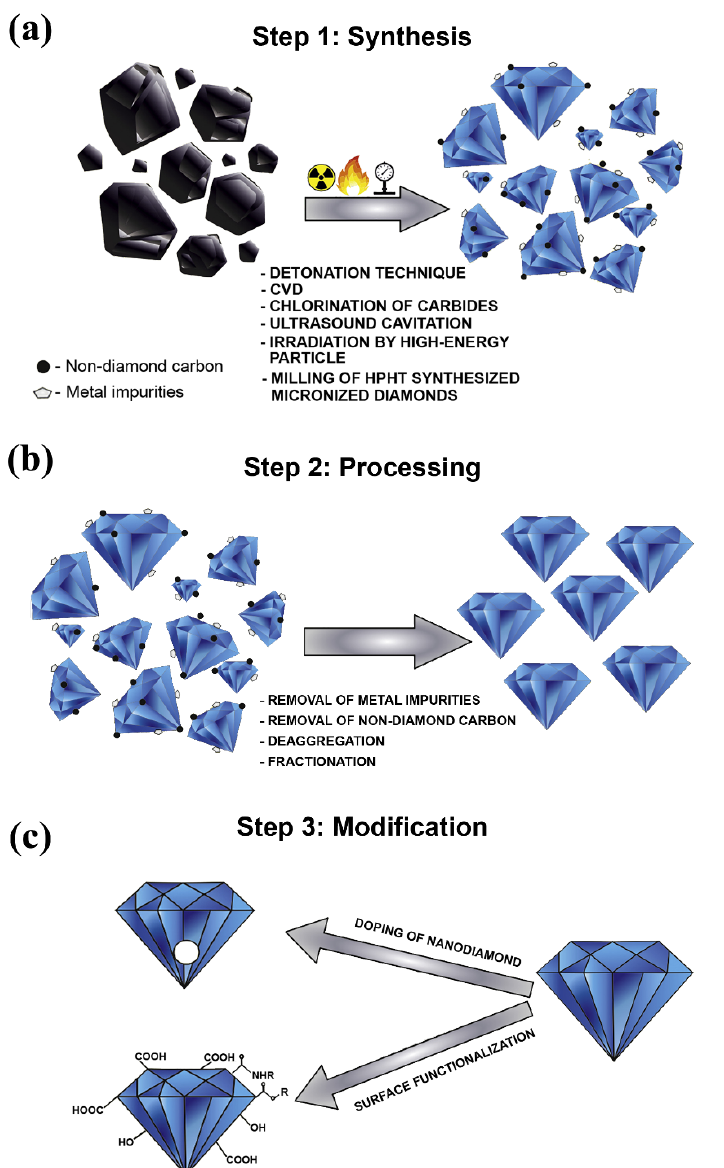
Figure 5. Phases involved in the production process of nanodiamonds, where ( a ) illustrates the synthesis phase, ( b ) demonstrates the processing phase, and ( c ) shows the modification phase. Reproduced with permission from [84]. Elsevier, 2019.